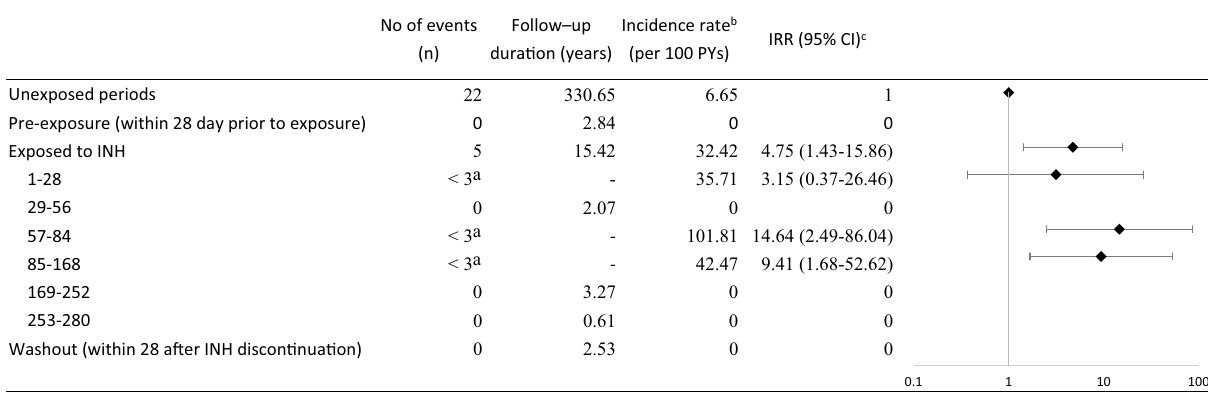
Table 4. Sensitivity analysis of risk of severe hepatitis before and after treatment with isoniazid (excluding death cases) (n = 27). a Numbers less than 3 considered as identifiable. b Incidence rate was reported as per 100 person- years. c Incidence rate ratios (IRR) were adjusted for covariates listed in Table